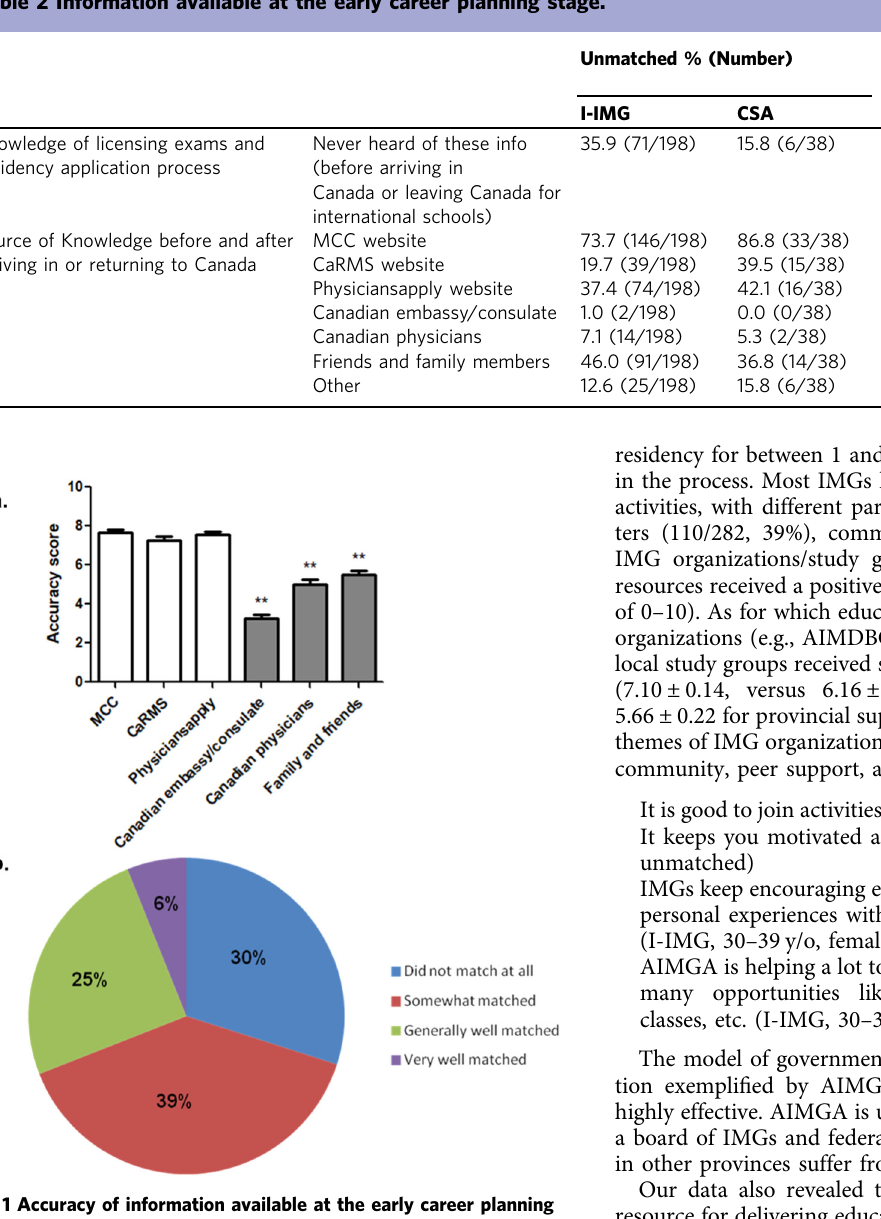
Table 2 Information available at the early career planning stage.